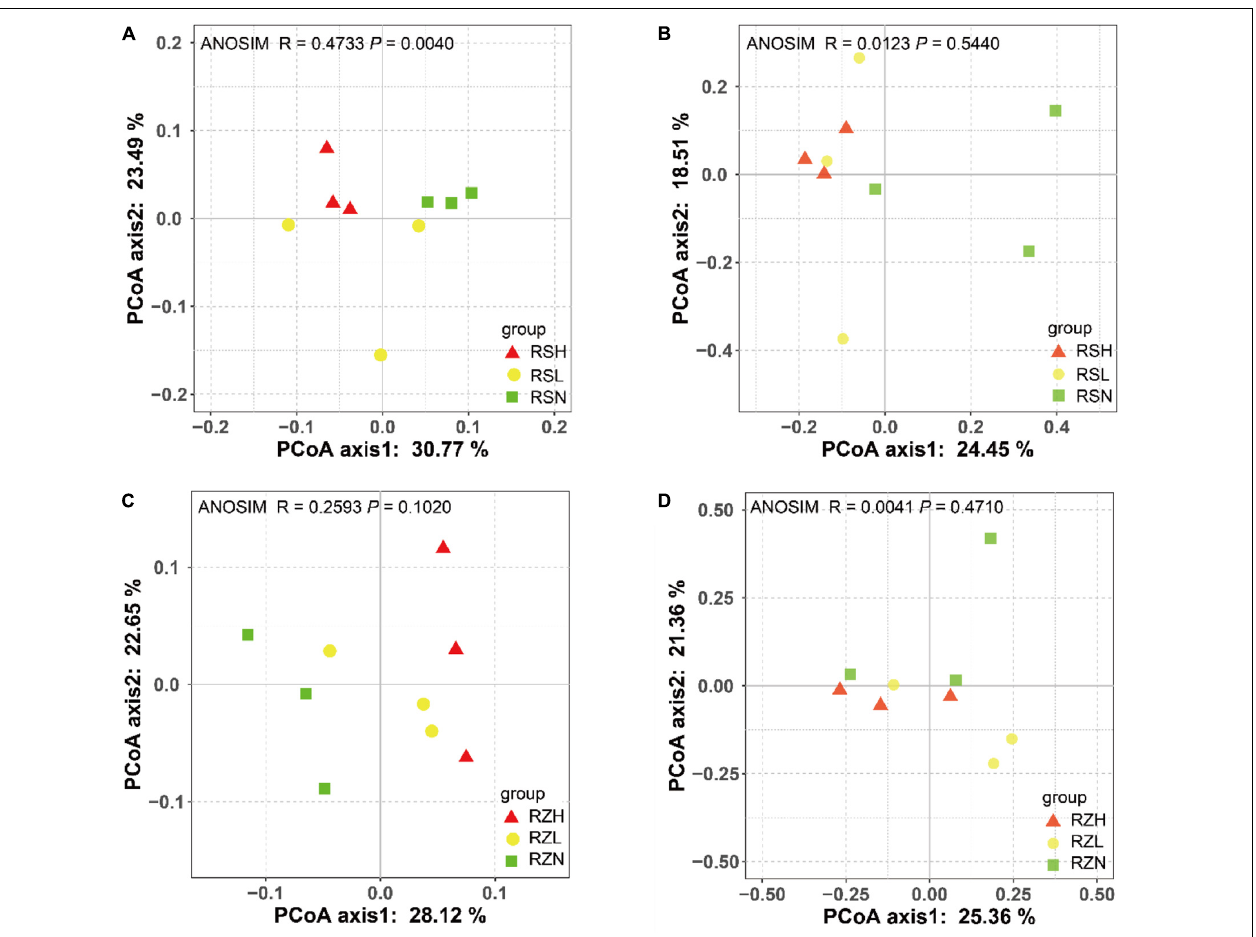
FIGURE 1 | Fusarium wilt separated the bacterial community in (A) RS but not that in (C) RZ, and it did not divide the fungal community in (B) RS or (D) RZ. PCoA was used to visualize the dissimilarity of bacterial and fungi compositions at the OTU level based on the Bray–Curtis metric. Red triangles, yellow circles, and green squares denote samples in group H (RSH and RZH), L (RSL and RZL), and N (RSN and RZN),